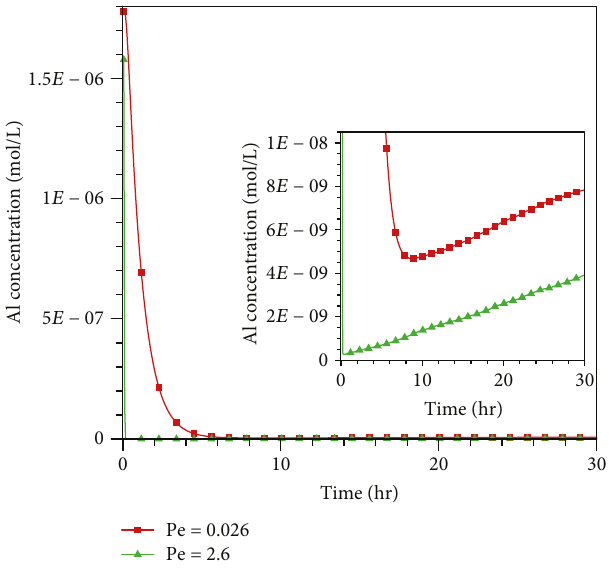
Figure 20: E ffl uent Al concentrations versus time at two di ff erent Pe